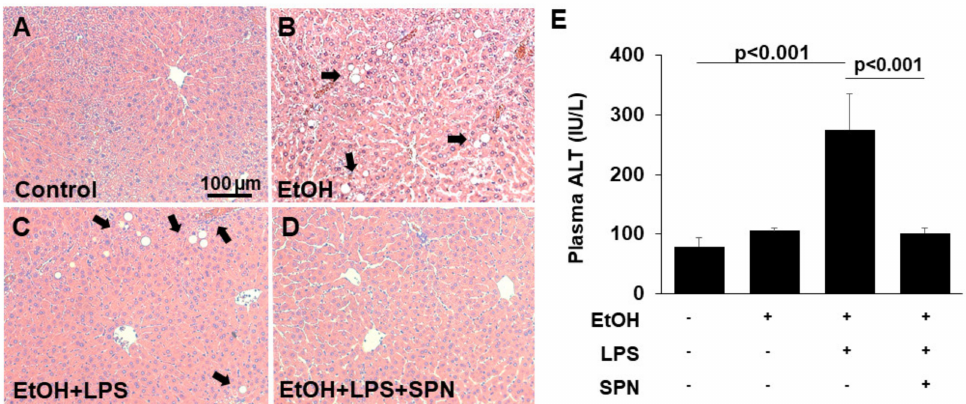
Figure 1. Spermidine prevents ethanol and LPS-induced liver injury. Thick (4–6 µ m) sections from mouse livers treated in the absence (control) or presence of ethanol (EtOH), LPS and/or spermidine (SPN) as indicated were stained with hematoxylin and eosin using routine procedures ( A – D ). Arrows indicate lipid droplets ( B , C ) and areas of inflammatory cell infiltration ( C ) that are absent in sections from control ( A ) or spermidine-treated mice ( D ). Bar = 100 µ m. ( E ) Plasma levels of ALT were determined in control or treated mice as indicated. For each experimental condition, four mice were anlayzed ( n = 4). The values in E represent the means of triplicate experiments ±